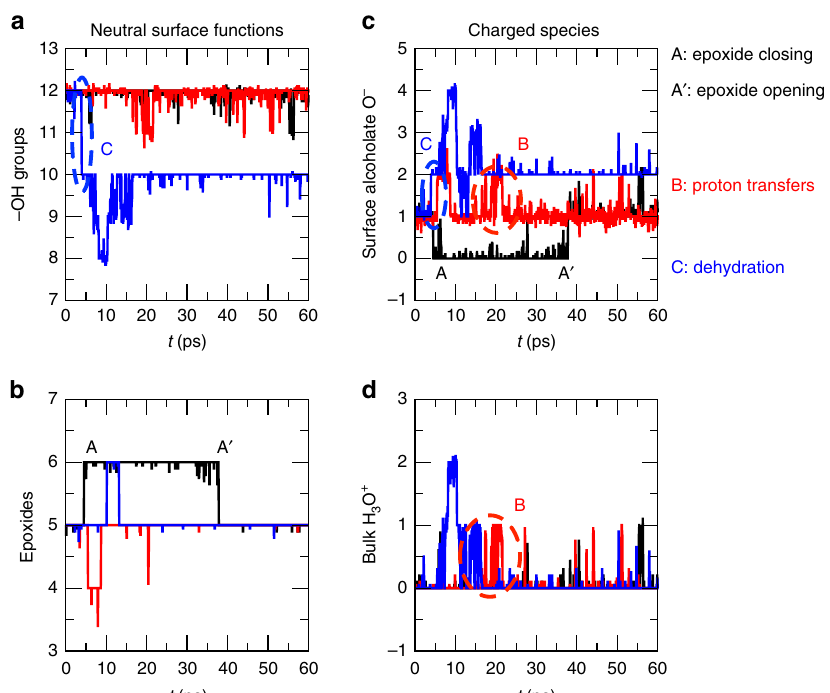
Fig. 5 Dynamics of graphene oxide in liquid water. Time evolution of the number of neutral functional groups of the GO surface (left) and charged species present at the GO surface or in the water bulk (right). a – OH groups. b Epoxides. c Surface alcoholate. d H 3 O + . The black, red, and blue curves are associated to the semiordered 1, 3, and 4 GO models, respectively. Some reactive events occurring in the GO dynamics in water are also identi fi ed and marked with capital